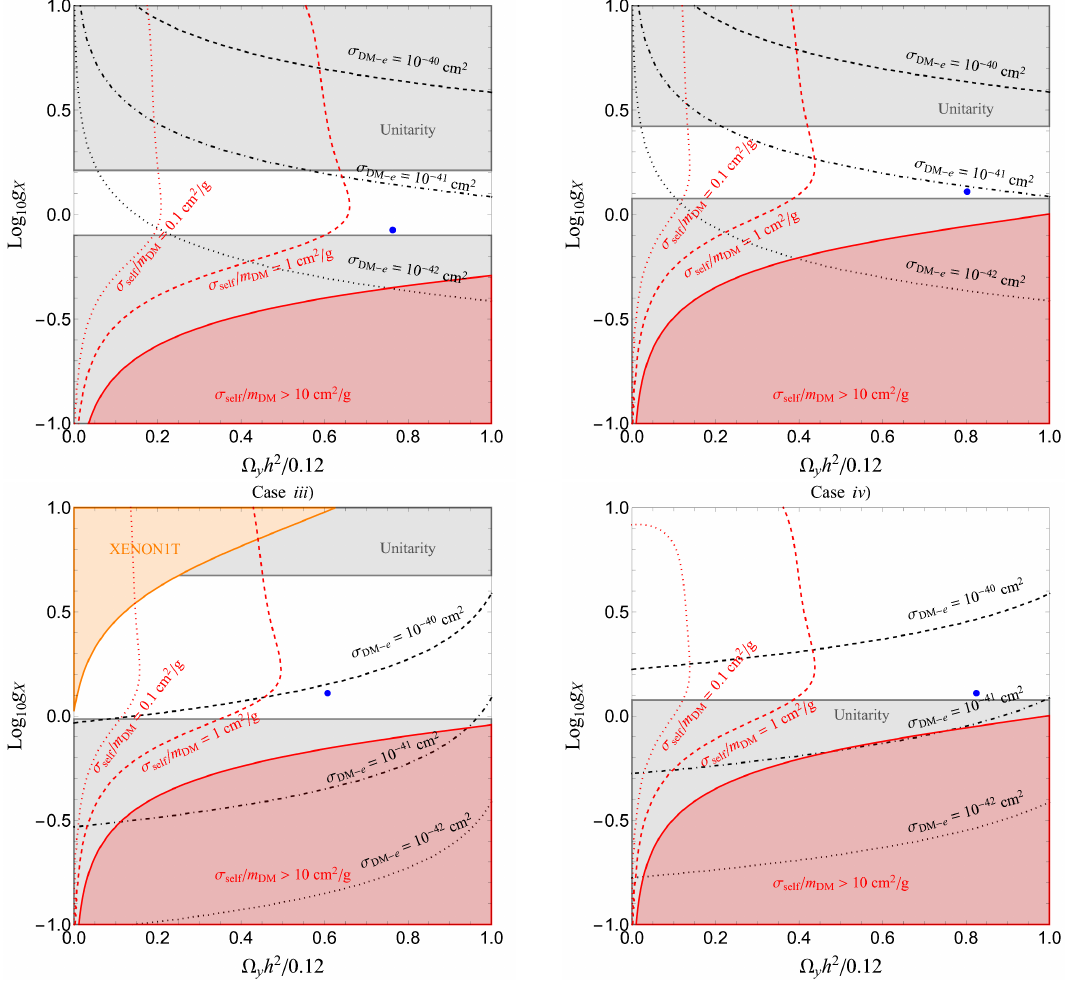
Figure 2 . For each case, the unitarity bound (grey), direct detection bound (orange), and large self-scattering cross section bound σ 10 cm 2 / g (red) are shown for different values of the self /m DM > dark gauge coupling g and the fraction of the Y relic density Ω 2 / 0 . 12 . The black lines represent X y h DM-electron scattering cross section values, 10 − 40 cm 2 (dashed), 10 − 41 cm 2 (dot-dashed), and 10 − 42 cm 2 (dotted) from top to bottom, respectively. The red lines correspond to two different values of the self-scattering cross section, 0 . 1 cm 2 / g (dotted) and 1 cm 2 / g (dashed). For details of the